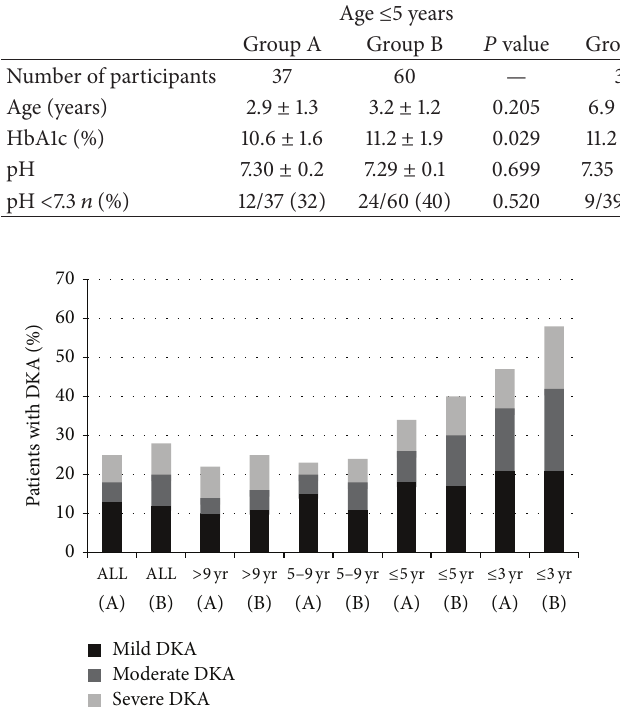
Figure 1: The rate of children with diabetic ketoacidosis (DKA) and distribution by severity of DKA in groups A (2006-2007 years) and B (2013-2014 years) in all patients and in different age